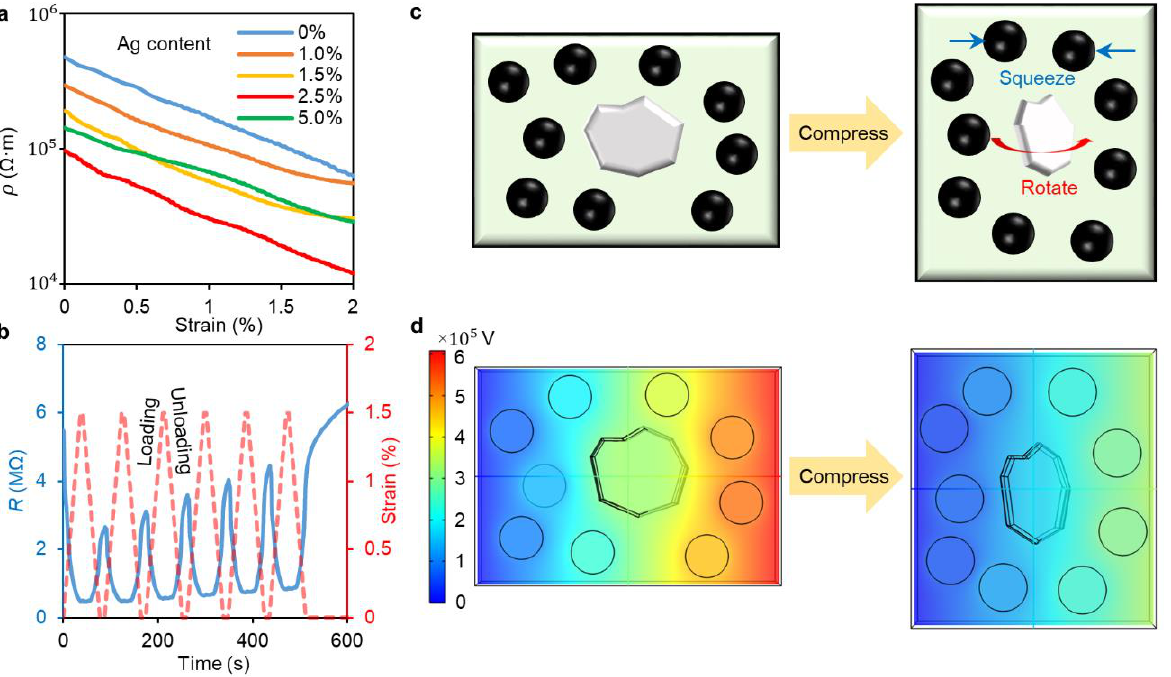
Figure 2. ( a ) Resistivity-strain curves of P-Fe-Ag y under compression. ( b ) Resistance-strain curve of P-Fe-Ag 2.5 under cyclic compression. The sample is pre-compressed at 0.5% strain and cyclic com- pressed further 1.5% strain. ( c ) Schematic diagram of microstructure changes during sample com- pression. ( d ) Numerical simulation of the changes in mechanical and electrical properties of samples before ( left ) and after ( right ) compression.